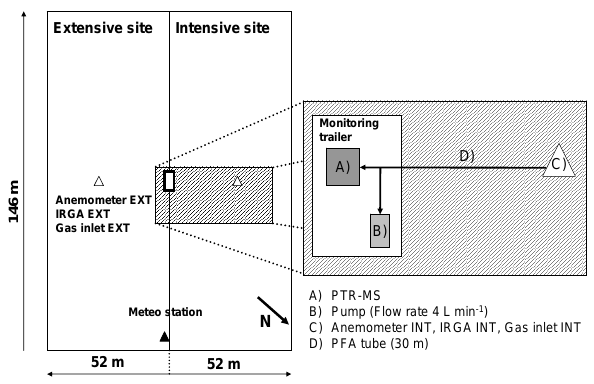
Fig. 1. Site sketch: Left: Position of the monitor trailer, the me- teo station, the two anemometers, the two open-path infra-red gas analyzer (IRGA) and the gas inlets above the two fields. Right: Measurement arrangement: Gas inlet, pump, and